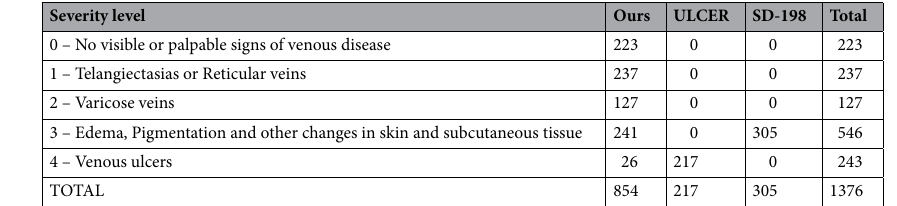
Table 1. Distribution of the dataset images per severity